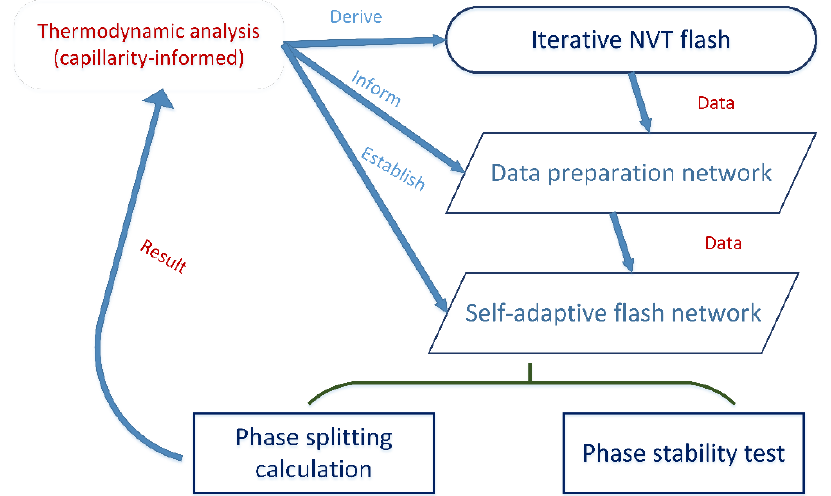
Figure 1. Structure of the thermodynamically consistent phase equilibrium calculation scheme considering capillarity.